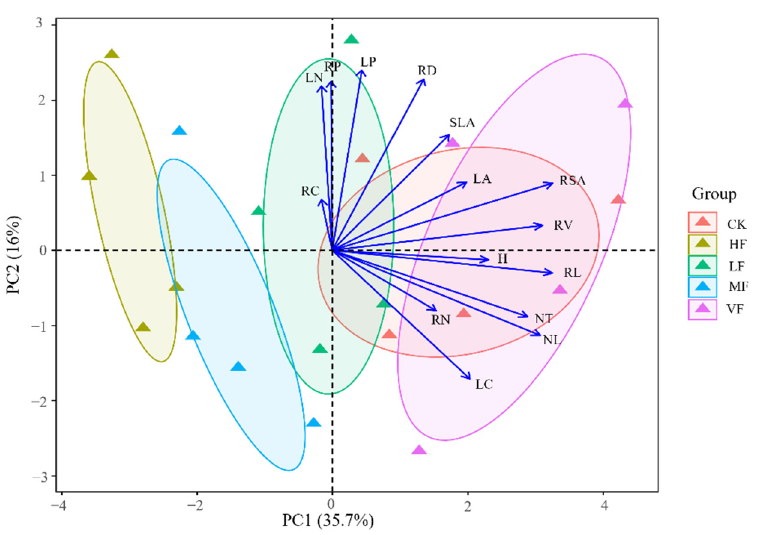
Figure 5. Principal components analysis (PCA) of C. thunbergii traits . (CK, no foraging; VF, very